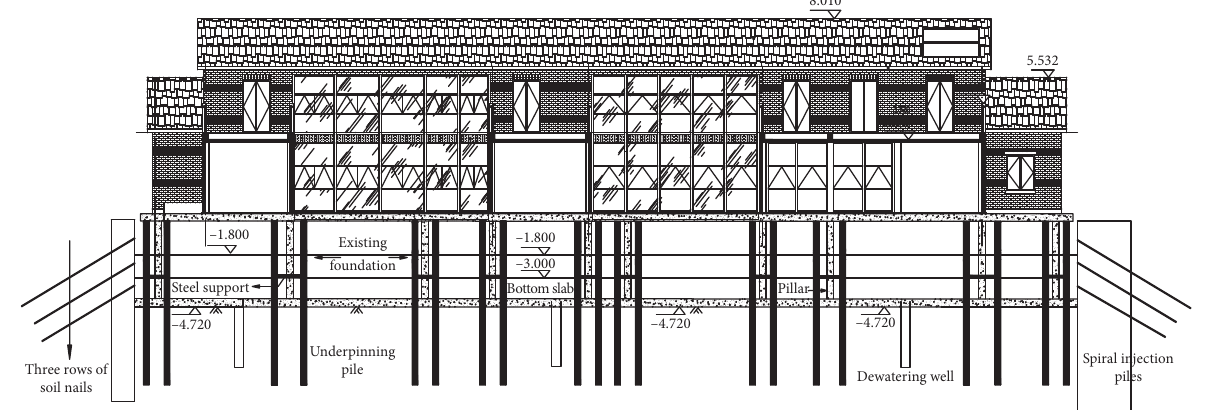
Figure 10: Excavating the third soil layer and pouring new structural